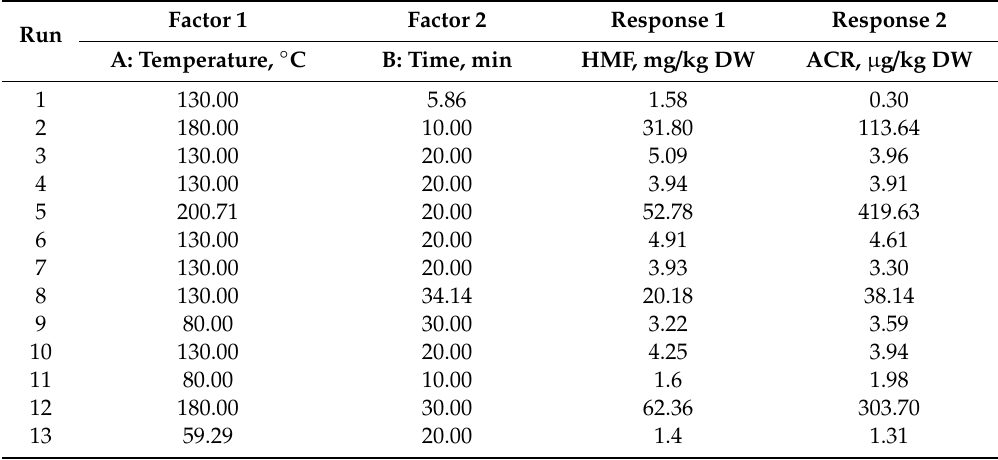
Table 3. Experimental data for the with responses.